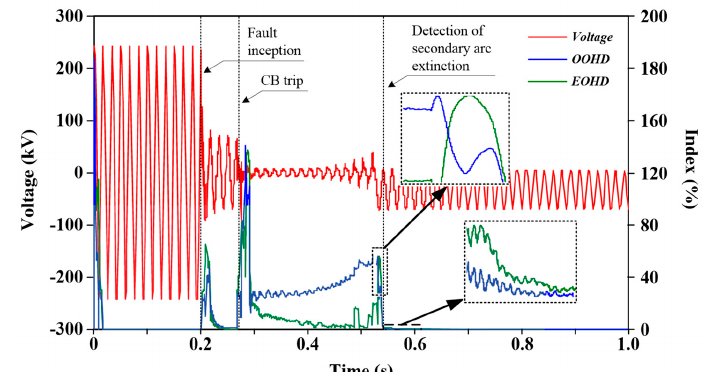
Figure 11. OOHD and EOHD results for the voltage waveform in Figure 4a.